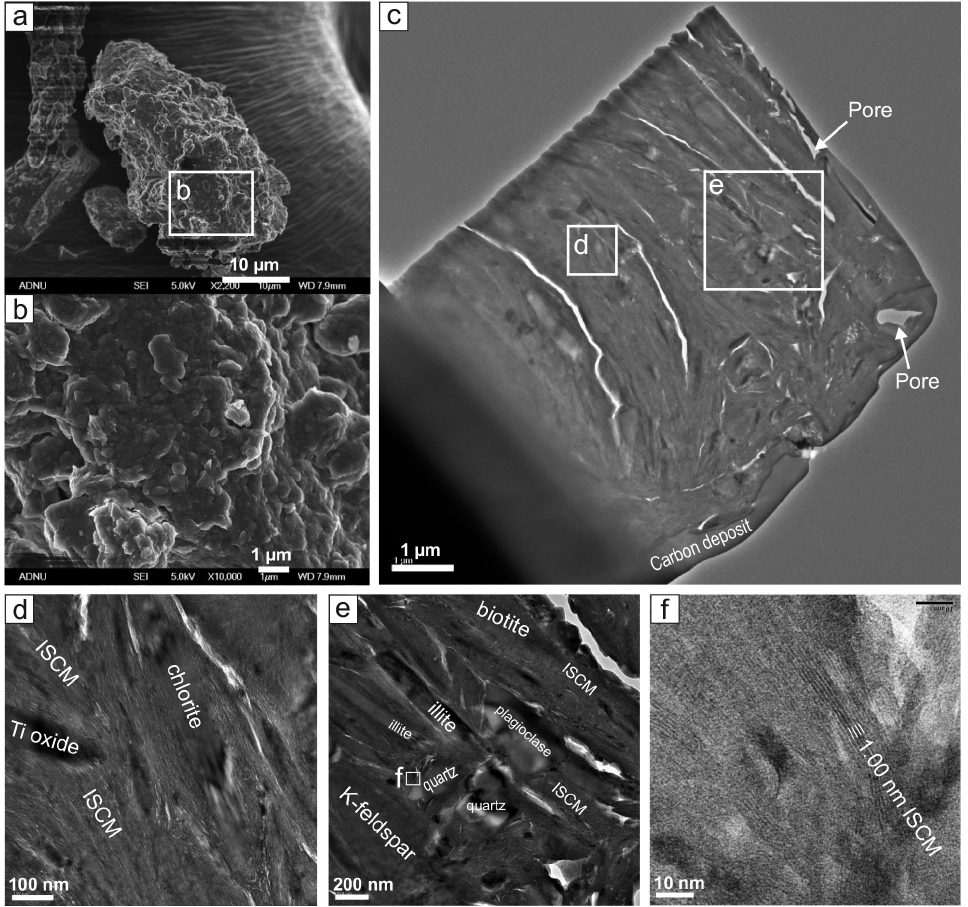
Figure 4. Clay-rich dust particle #3 from 2012 Asian dust. (a) SEM image of the dust particle. (b) SEM image of the particle surface magnified from the box in (a) . (c) Overall TEM image of the FIB slice prepared from the particle in (a) . (d, e) TEM images magnified from the boxes in (c) . (f) TEM lattice fringe image of